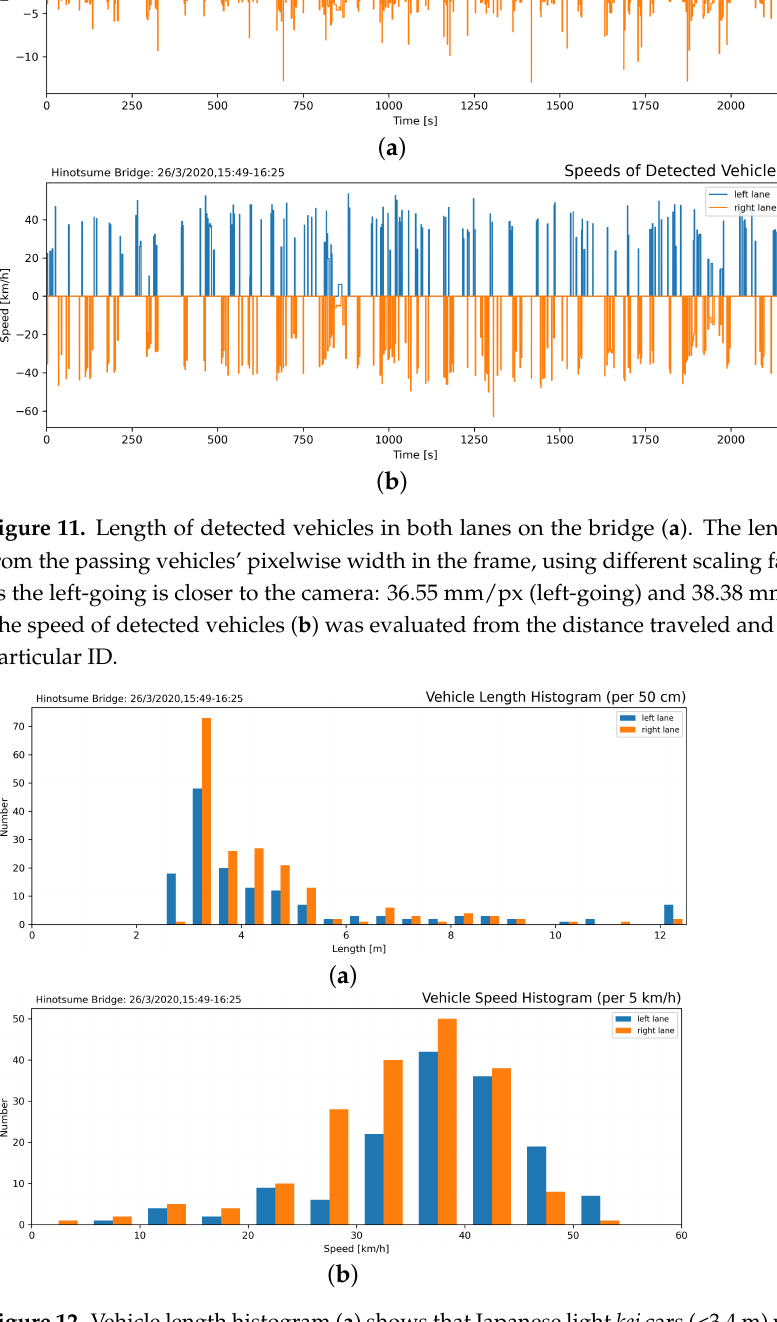
Figure 12. Vehicle length histogram ( a ) shows that Japanese light kei cars (<3.4 m) were most common. Passing speed histogram ( b ) shows that drivers adhered to the enforced speed limit (50 km/h). Displacement of markers obtained from DIC analysis, accompanied by its times- tamp, was cross-referenced with the timestamp from the traffic counting process to obtain correspondence between the passing vehicles and induced displacement on the